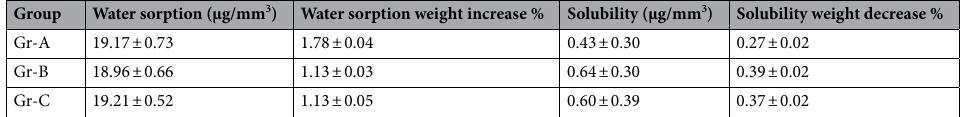
Table 3. Water sorption and solubility of tested groups.